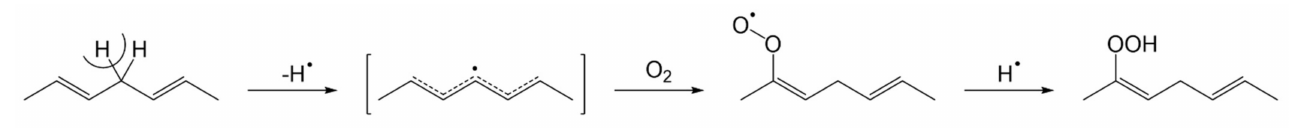
Figure 8. Lipoxygenase